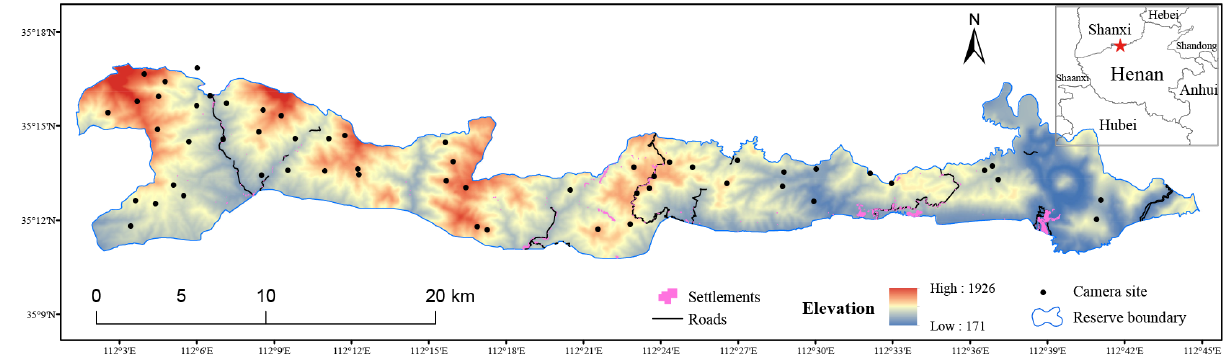
Figure 2. Study area and camera sites in the Taihang Mountain Macaque National Nature Reserve, Jiyuan city, Henan province,